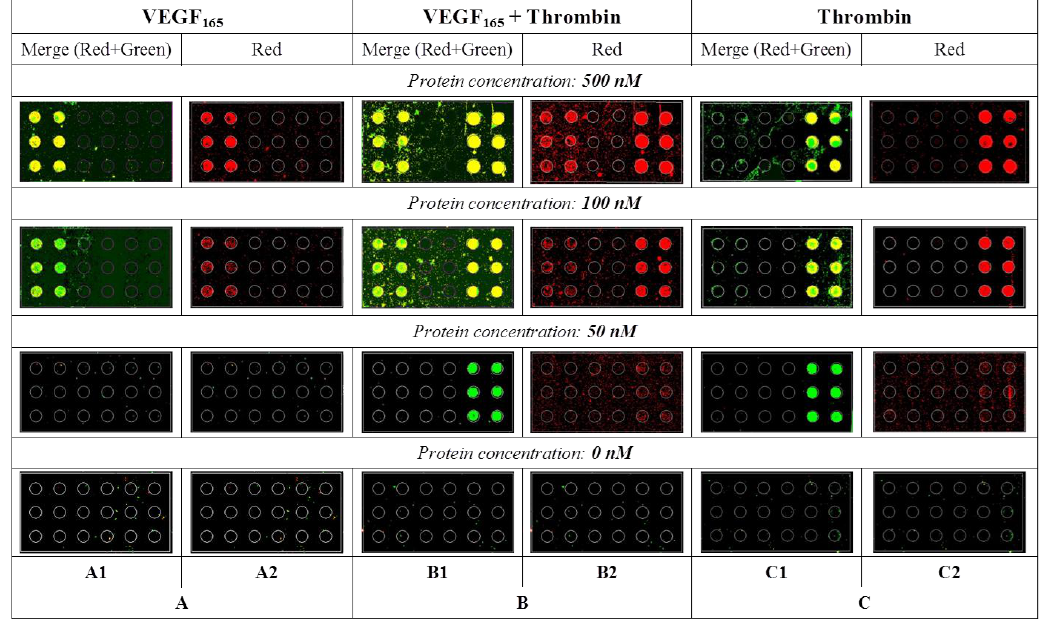
Figure 4. Images of the microarray slides reporting the multiplex SAM for VEGF and 165 thrombin detection. The six spots printed with Vap7(12T)NH are on the left of each 2 subarray and the six spots printed with TBA1(12T)NH on the right. Panel A reports the 2 detection of human VEGF , Panel C the detection of human thrombin. Panel B reports 165 the simultaneous detection by each aptasensor of the specific target mixed in solution. Each protein, at the same concentration, was then incubated separately with its own specific detection aptamer (VEa5-Cy5 or TBA2-Cy5) and analyzed on the glass slide. Cy-5 detection aptamers, namely VEa5-Cy5 for VEGF or TBA2-Cy5 for thrombin, were 1 165  M. Glass slides A1, B1 and C1 were incubated with Alexa-555 labeled proteins, while slides A2, B2 and C2 were incubated with unlabeled